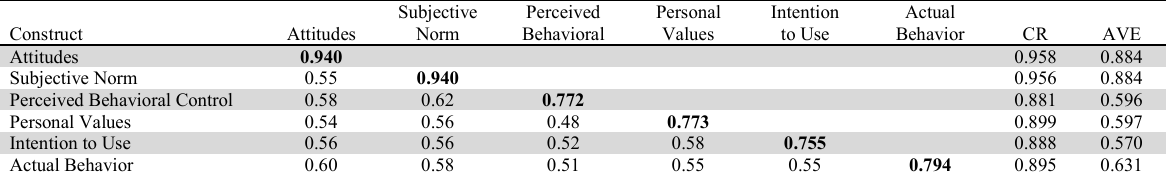
The Composite Reliability (CR) and Average Variance Extracted (AVE), and Discriminant Validity In- dex Summary for all Constructs